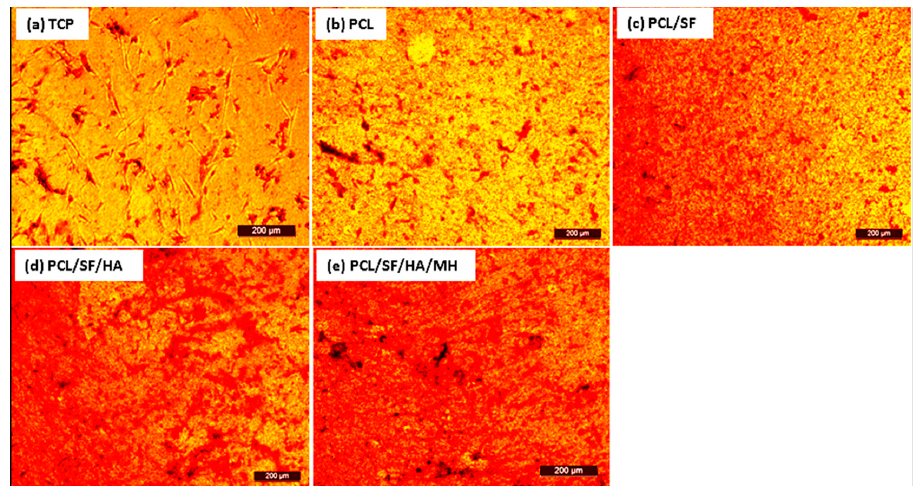
Figure 12. Optical microscopic images showing the secretion of minerals by osteogenic differentiation of MSCs. Alizarin red staining on day 15 in TCP ( a ), PCL ( b ), PCL/SF ( c ), PCL/SF/HA ( d ) and PCL/SF/HA/MH ( e ), (10× magnification).